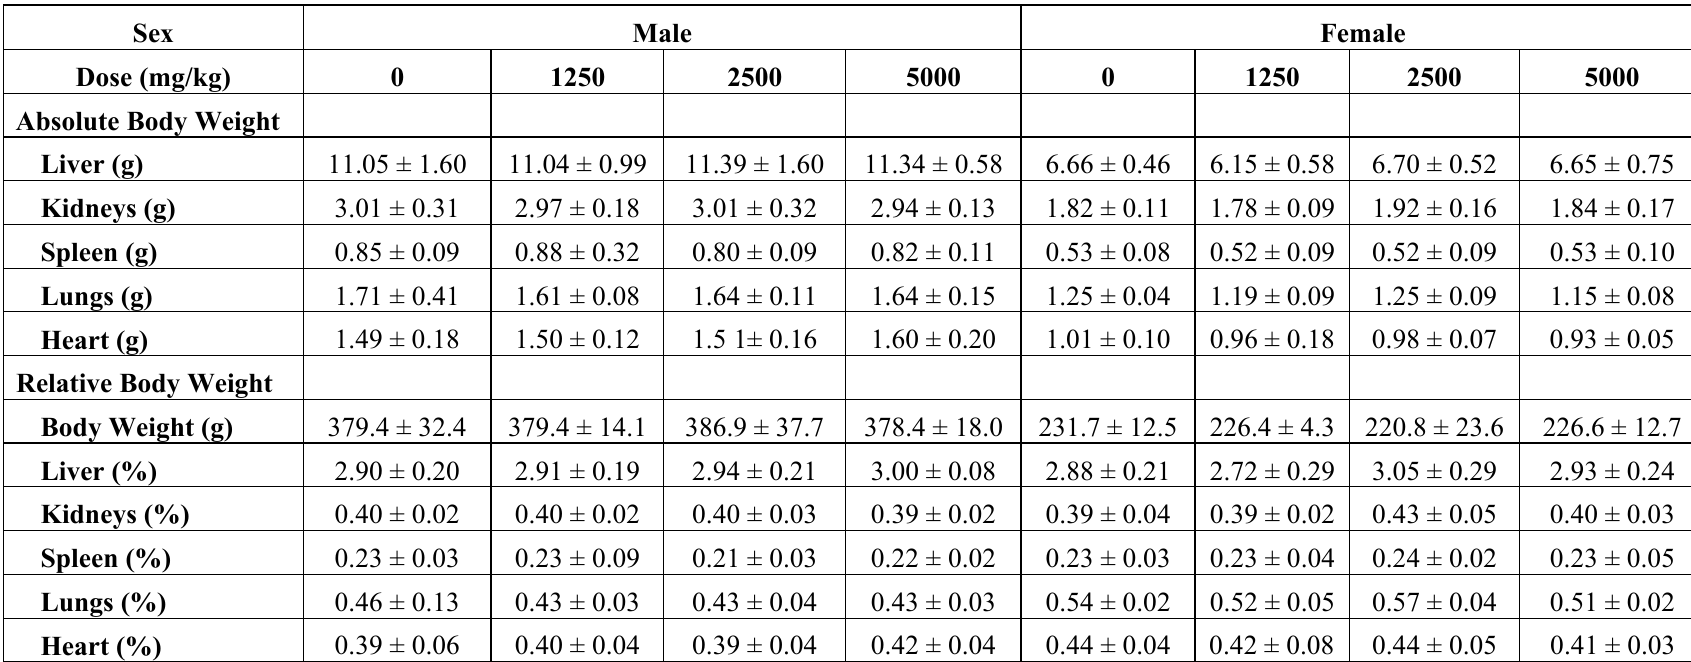
Table 6. Absolute and relative organ weights of male and female rats treated orally with C. setidens for 4 weeks. Sex Male